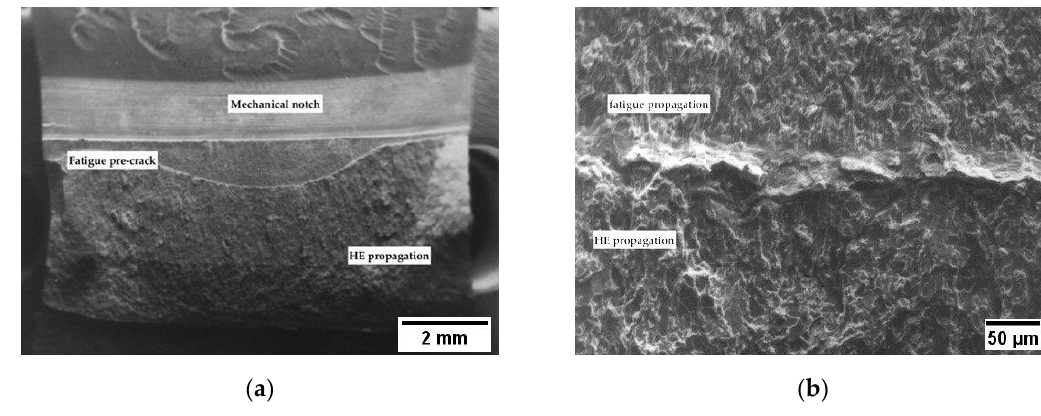
Figure 6. Fracture surface in J-integral test for X70 steel polarized at −1 V vs. SCE: ( a ) macro and ( b ) close-up view of the fatigue pre-cracking crack propagation transition zone.